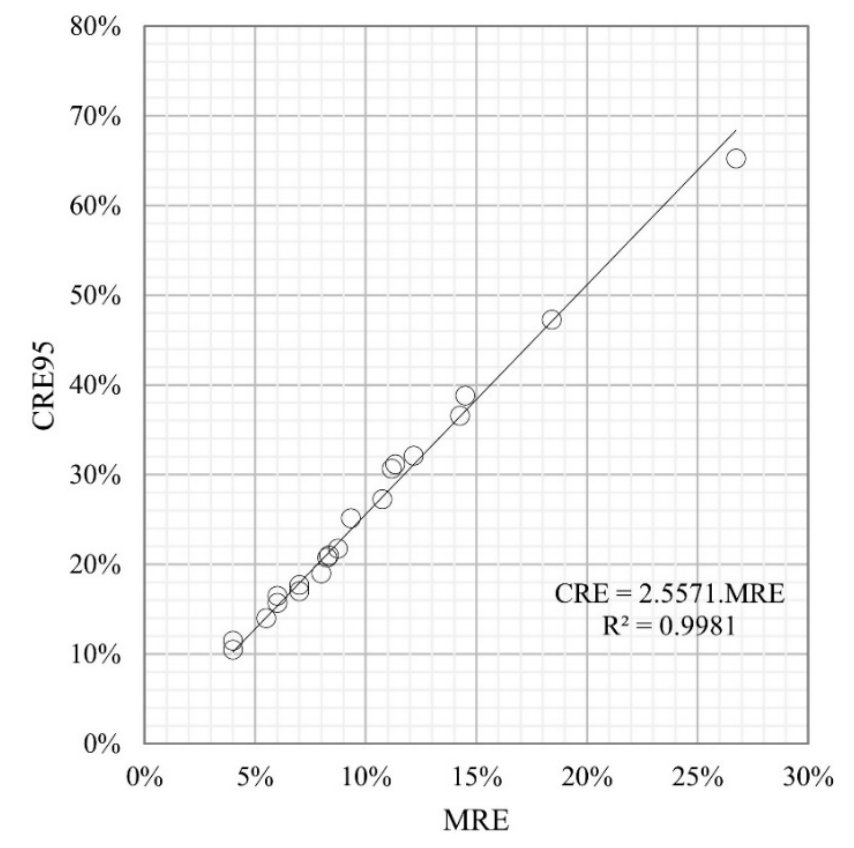
Figure 8. Relationship between mean error and 95th percentile error.